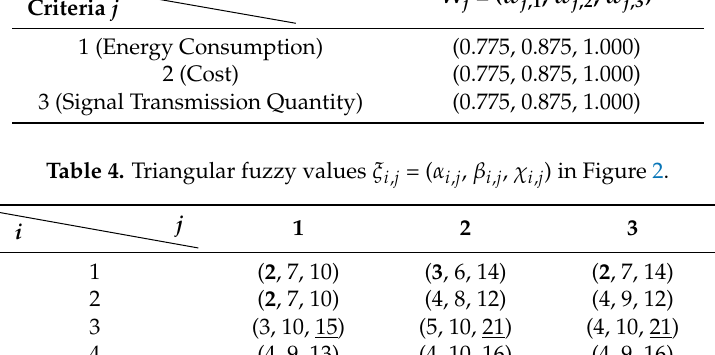
Table 5. Values of min